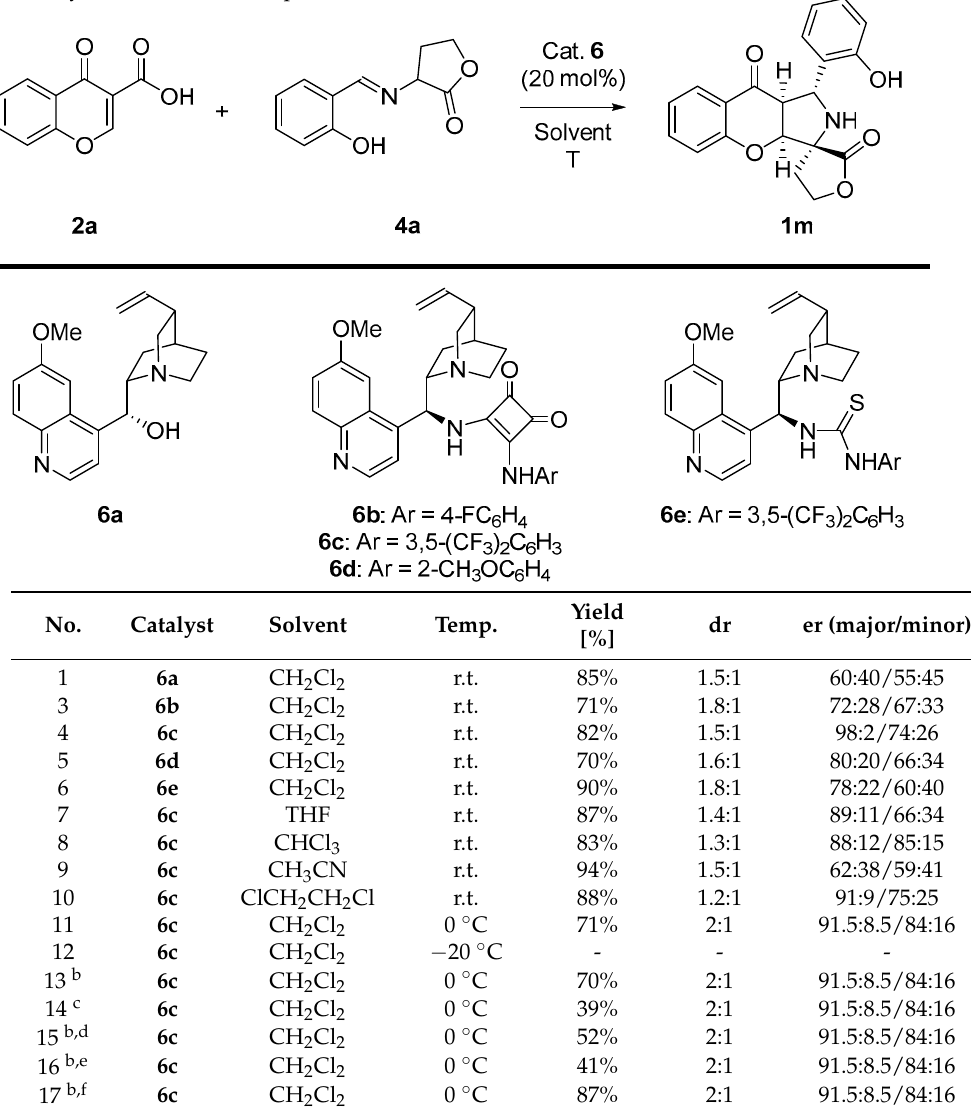
Table 2. Enantioselective, decarboxylative (3+2)-cycloaddition of chromone-3-carboxylic acids 2 and iminodihydrofuran-2-one 4 —optimization studies a .